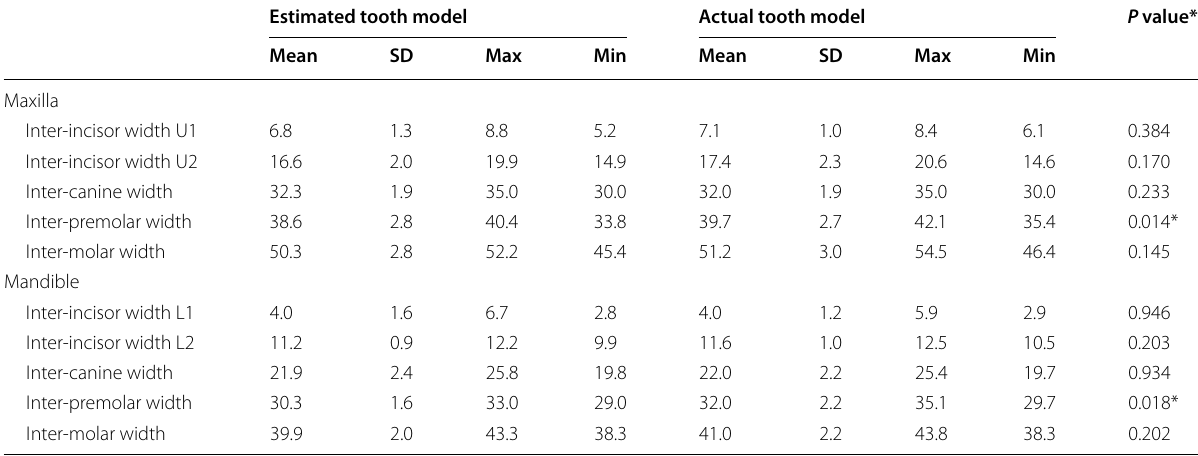
SD, Standard deviation *The results of paired t test. U1, maxillary central incisors; U2, maxillary lateral incisors; L1, mandibular central incisors; L2, mandibular lateral